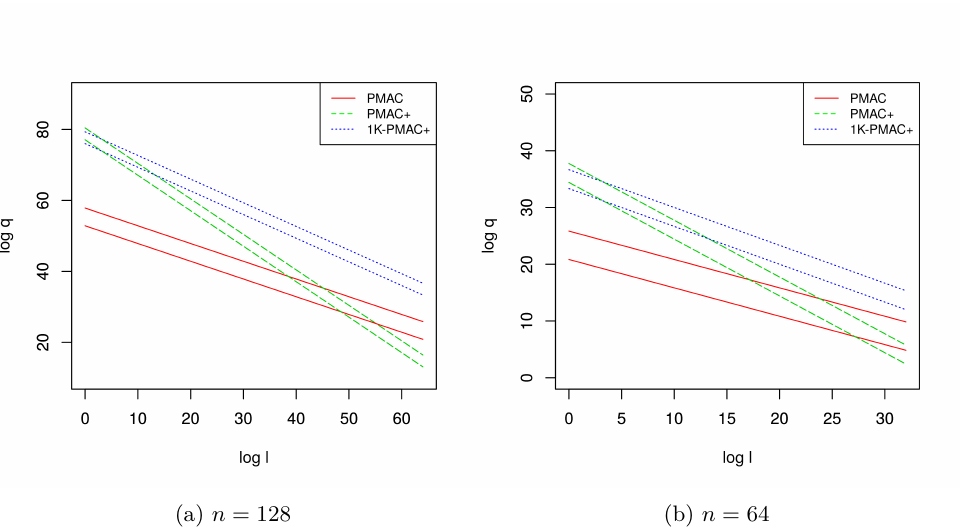
Figure 1.1: log ‘ vs log q graph for PMAC , PMAC_Plus and 1k-PMAC_Plus construction with (cid:15) = 2 − 10 , 2 − 20 . For a fixed construction the top curve is for (cid:15) = 2 − 10 and the bottom one is for (cid:15) = 2 − 20 . Observe that, for n = 128, PMAC and PMAC_Plus intersects at ‘ = 2 45 . 2 (2 48 . 5 ) for (cid:15) = 2 − 10 (2 − 20 ). So, for any ‘ beyond that, PMAC always achieves better security than PMAC_Plus . Similarly for n = 64, the intersecting ‘ values are 2 23 . 82 and 2 27 . 15